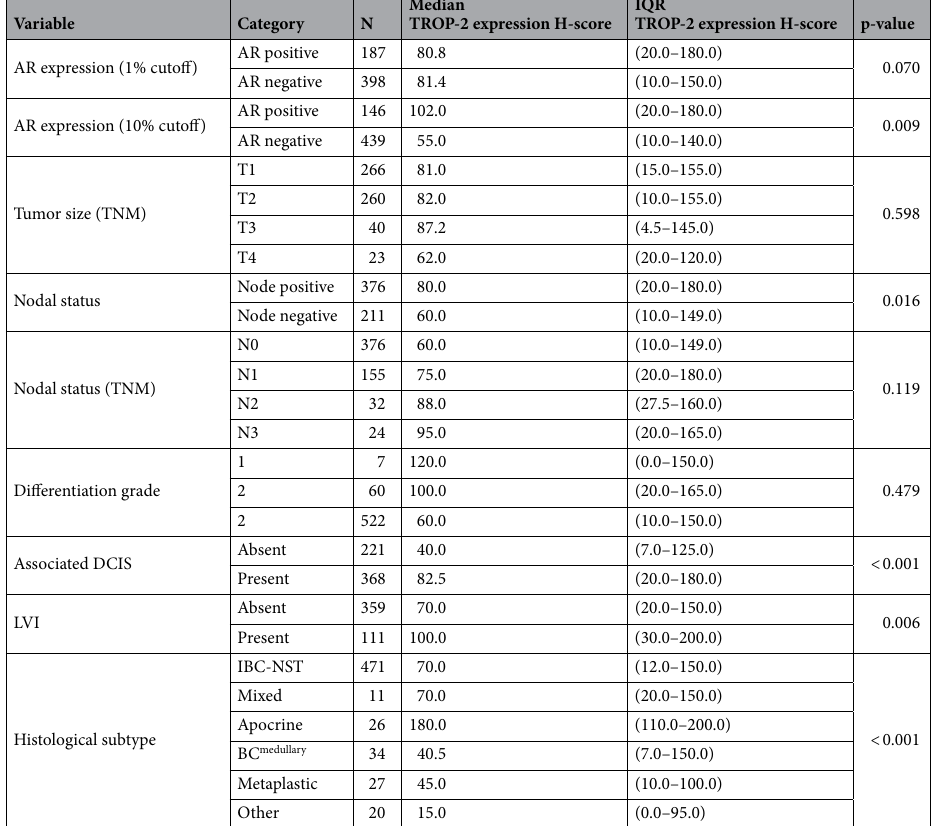
Table 4. Univariable analyses of interactions between continuous TROP-2 expression and categorical clinical– pathological factors. IQR inter-quartile range, AR androgen receptor, DCIS ductal carcinoma in situ, LVI